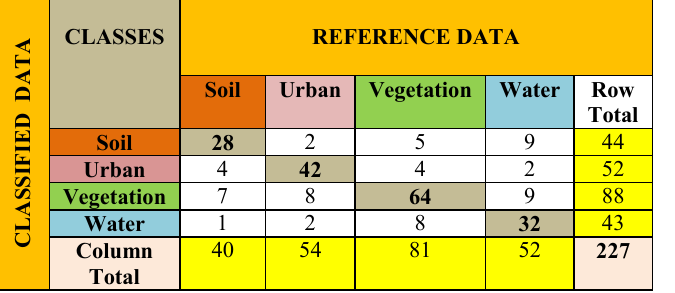
Fig. 1 Example for image